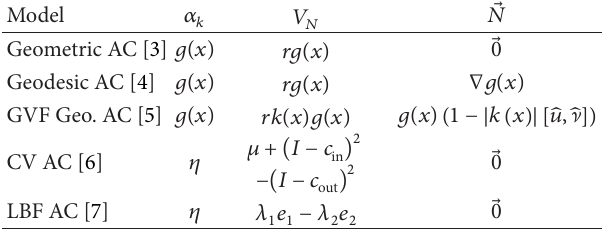
Table 1: The analysis table of energy function